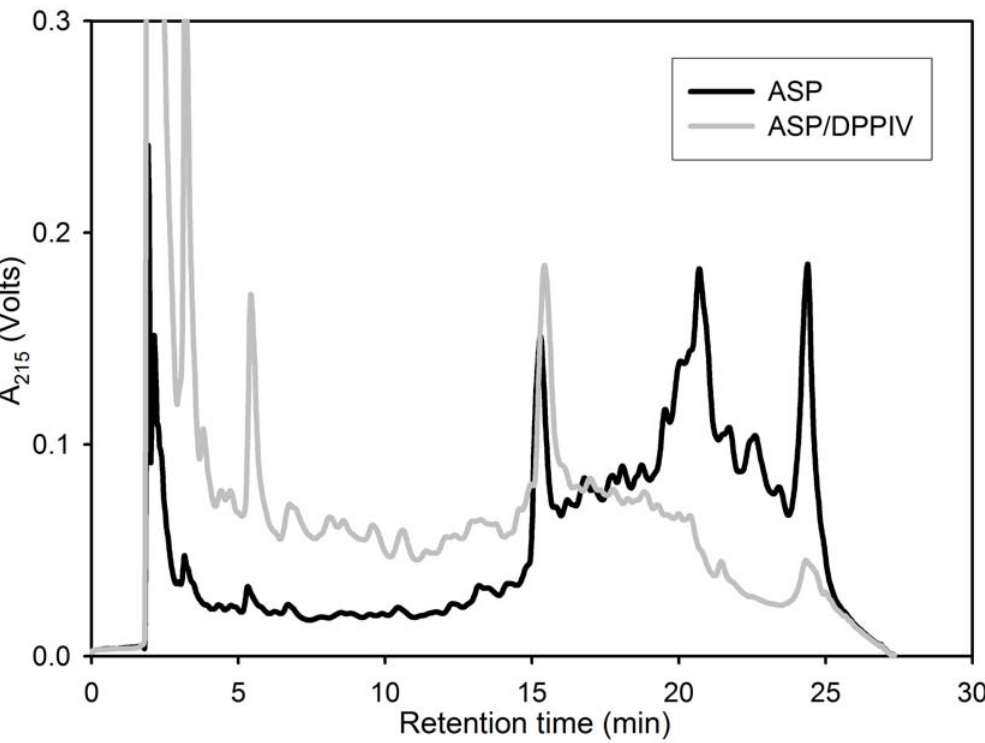
Figure 5. Effect of a food-grade dipeptidyl peptidase IV (DPPIV) preparation on gluten proteolysis by aspergillopepsin (ASP). Whole gluten powder (50 mg/ml) was incubated for 60 min at 37 u C with 0.35 mg/ml ASP in the presence or absence of 0.7 mg/ml DPPIV. Because this enzyme preparation is inactive at pH , 4, the reaction was conducted in 0.03 M HCl in the presence of 1.5 mg/ml CaCO 3 to simulate addition of a standard over-the-counter antacid/calcium supplement. The pH of the resulting mixture varies between 4–5 for the duration of the reaction. The peak at 15 min corresponds to an internal standard (TAME).